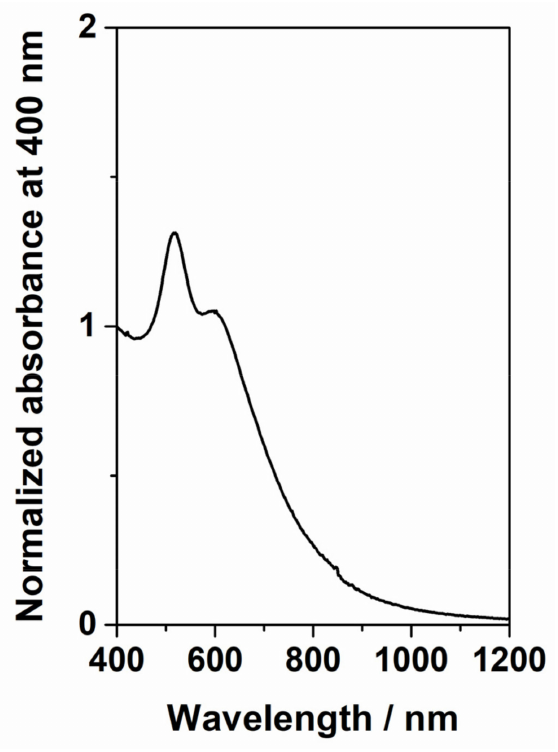
Figure A2. Representative extinction spectra for the 14 nm AuNP